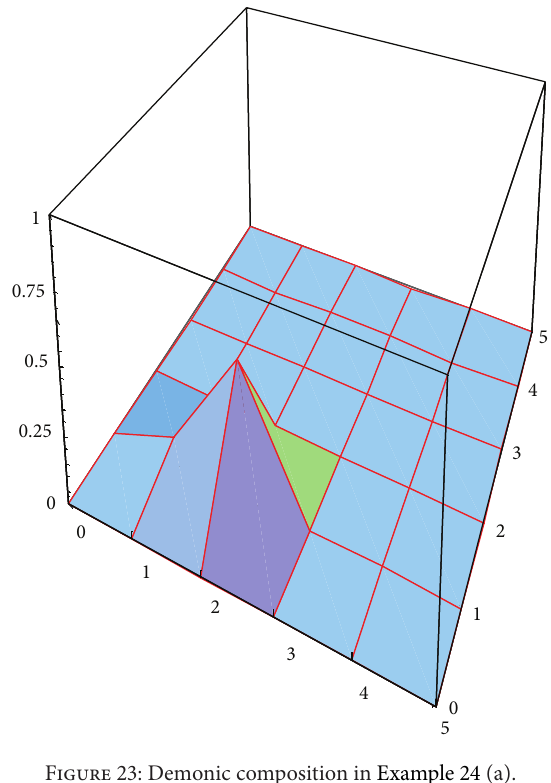
Figure 23: Demonic composition in Example 24 (a).